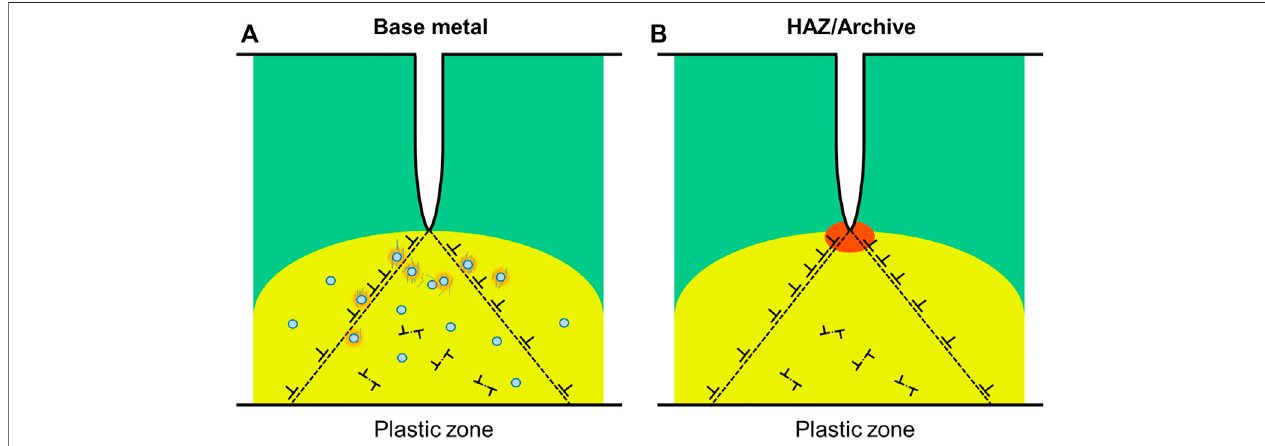
FIGURE7| Schematicrepresentationofthecracktipbluntingmechanismsplasticzoneaheadofthecracktip. (A) Basemetalhasahigherdensityofcavitieswhich couldactivatemartensitictransformation. (B) Sinceonlycrackbluntingoccursduringbending,theplasticzoneunderthecracktipisrepresented bytheyellowregionas ductile behavior with an orange-highlighted stress concentration area immediately ahead of the crack and dislocations nucleates from the crack tip as well as active sources.